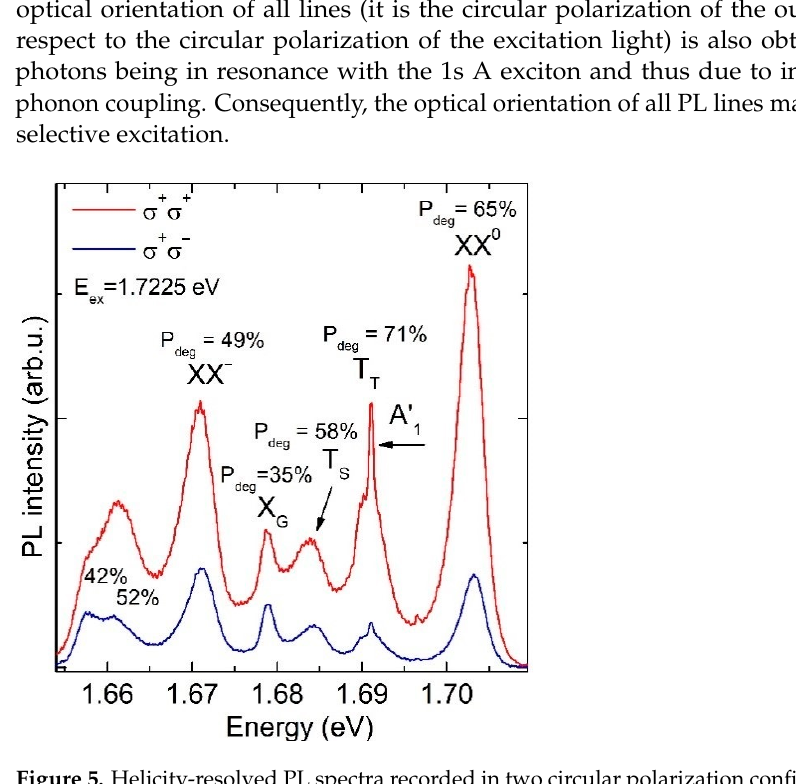
Figure 4. Degree of circular polarization plotted as a function of excitation energy for: ( a ) neutral A exciton (X A ) and biexciton (XX 0 ), ( b ) negative trion in the singlet (T S ) and triplet (T T ) state, ( c ) nega- tively charged biexciton (XX − ), ( d ) Raman modes ZO (hBN) and ZO (hBN) + A ′ 1 (WSe 2 ).